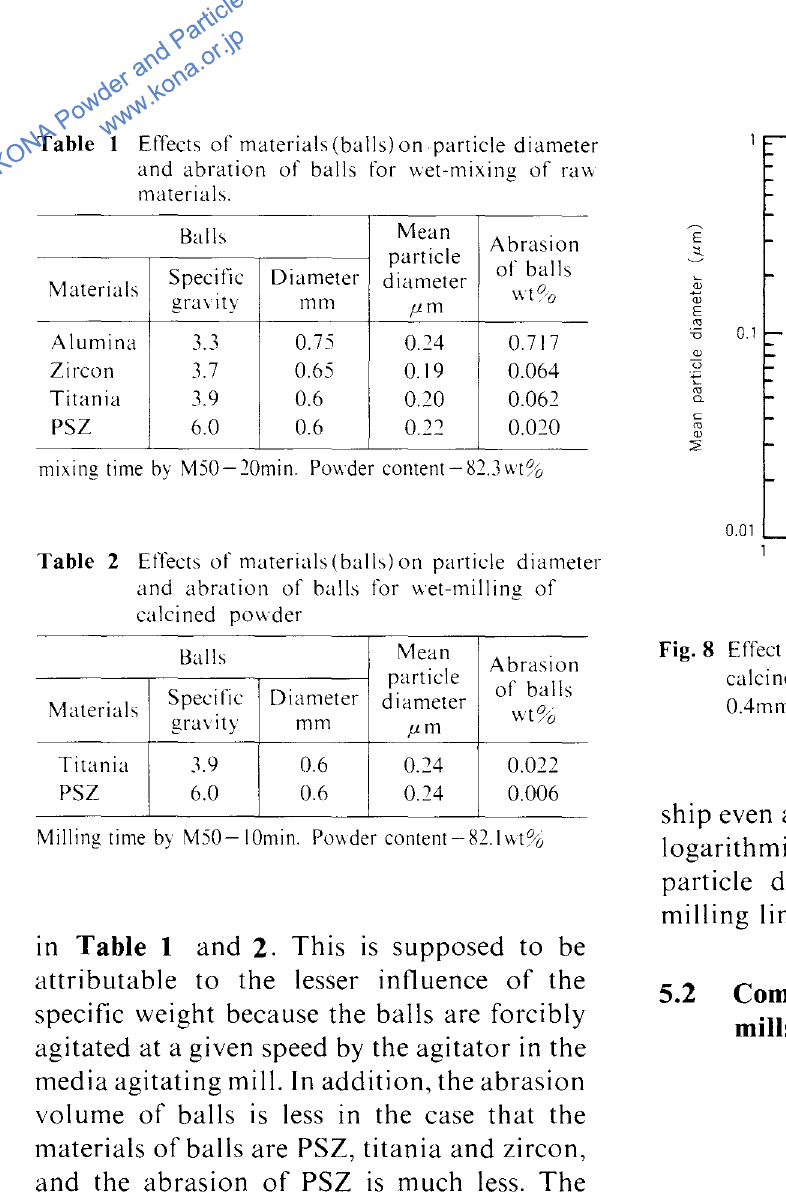
Table 2 Effects of materials(balb)on particle diameter and abration of balls for wet-milling of